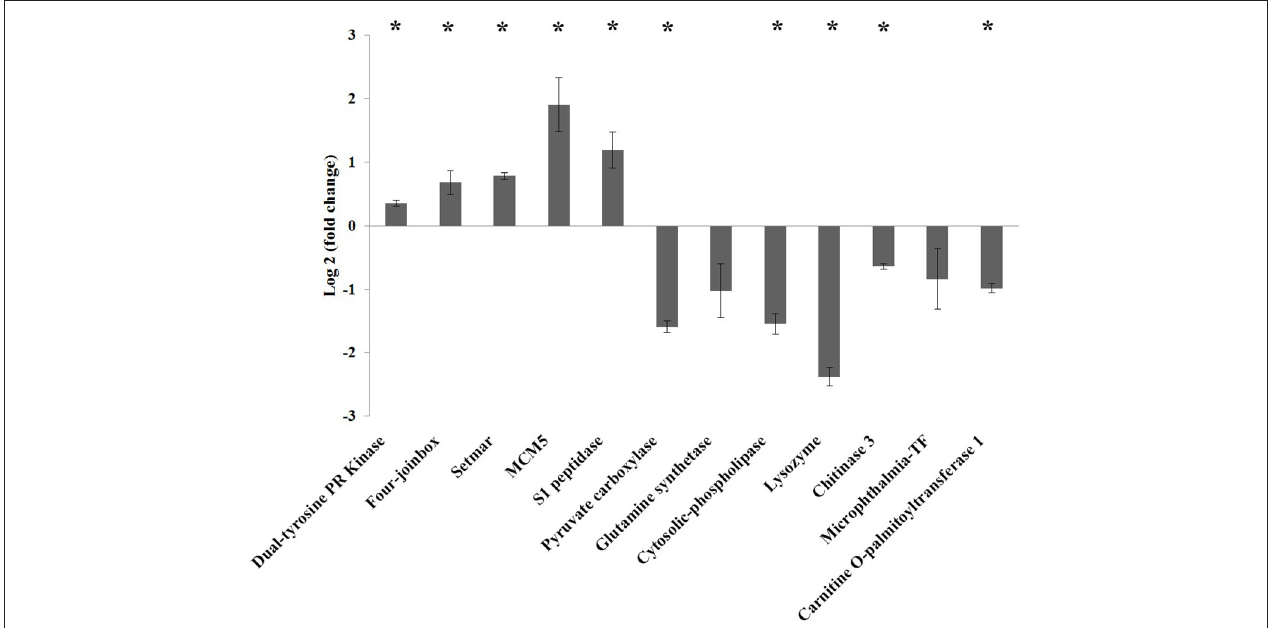
FIGURE 5 | Gene expression by qPCR on a selection of differentially expressed genes induced by diet (M vs. A, comparison). Results are presented as mean ± standard error of log2 fold change. Significant differences compared to controls are indicated with an asterisk ( p < 0.05).